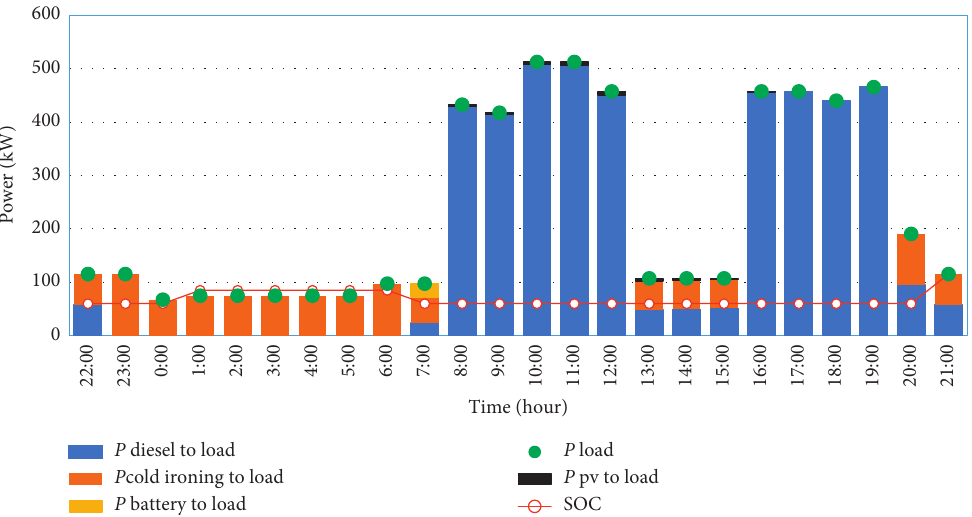
Figure 8: Hybrid energy management system case 3.